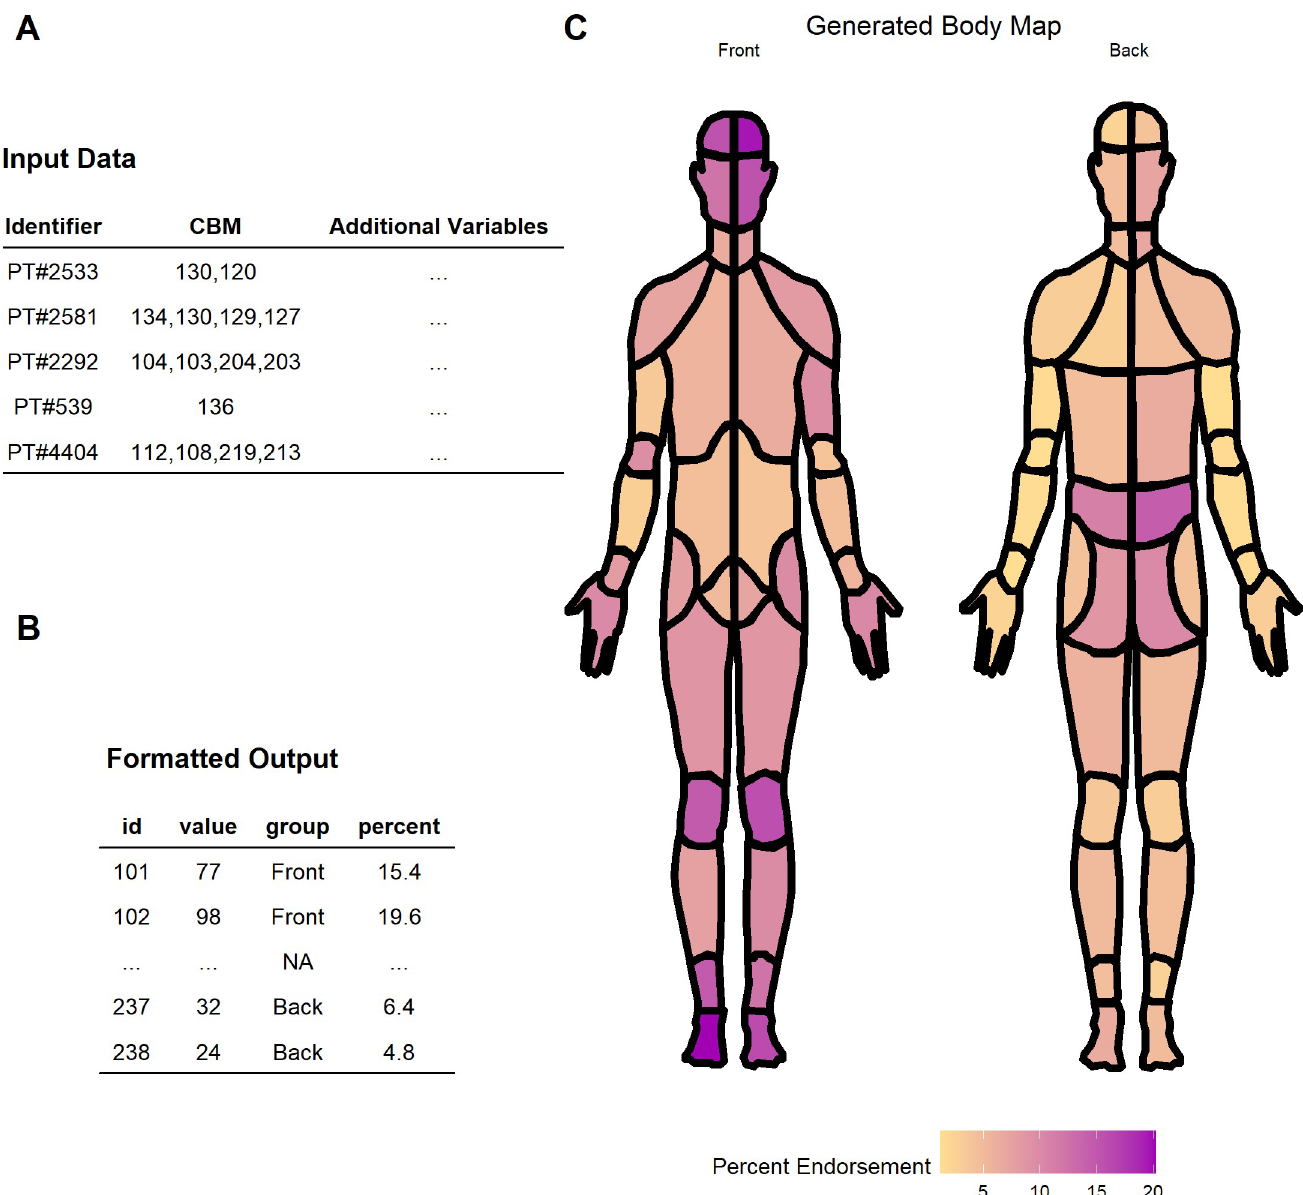
Fig 2. (A) Example of the format for an input data.frame for the CHOIRBM package. (B) Example of an output data.frame ready for plotting. Note, only the first two rows and last two rows are shown. (C) Example data from (A) and (B) plotted in a CBM.